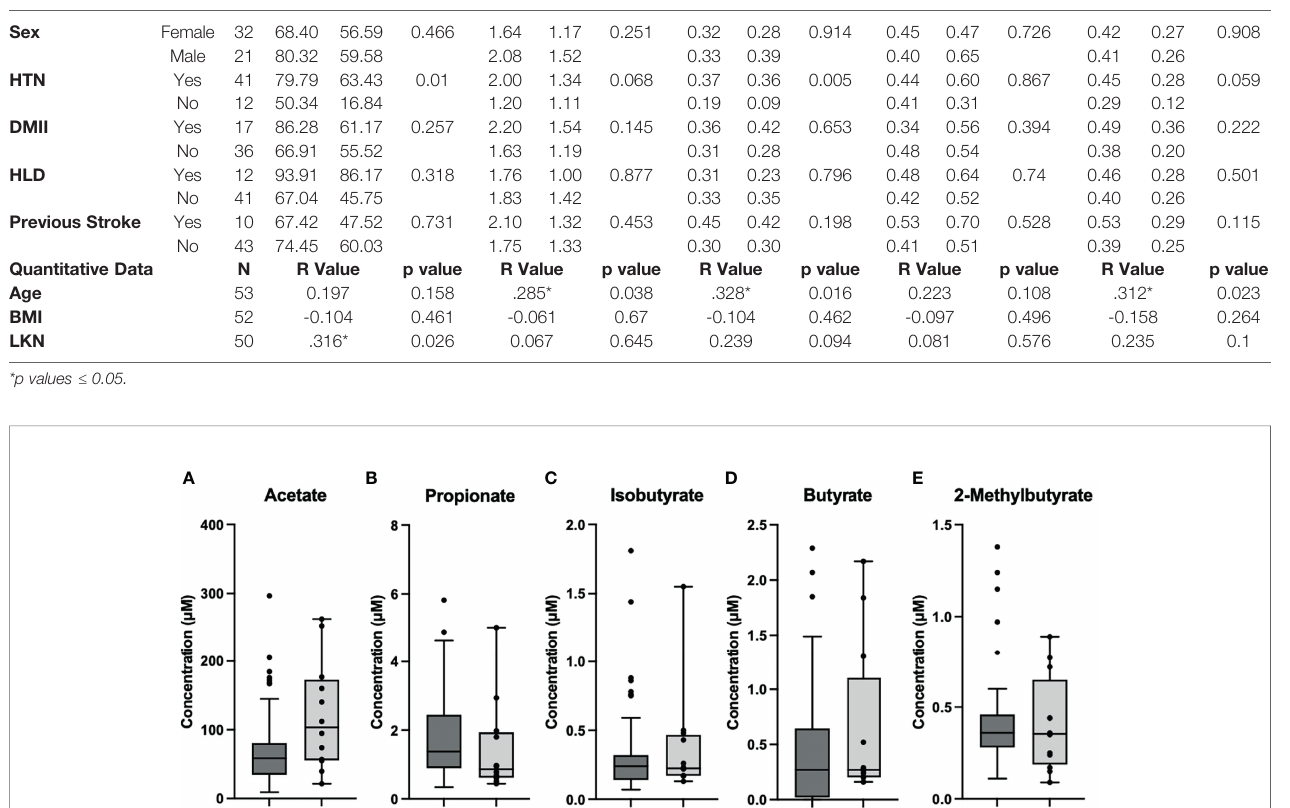
Interleukin-6 (IL-6) taken from intracranial plasma demonstrated four SCFA correlations (Propionate: p=.026, Figure 5 ) and intracranial (p=0.047; R 2 = 0.076; Figure 5 ) correlations with NIHSS admission. The mean systemic and intracranial levels of IL-6 were also signi fi cantly different between strati fi ed NIHSS admission groups (p=0.032). On contrast testing, it was found that systemic (p=0.061) and intracranial (p=0.049) IL-6 were speci fi cally higher in severe stroke (NIHSS = 15-24) compared to mild stroke (NIHSS < 5).